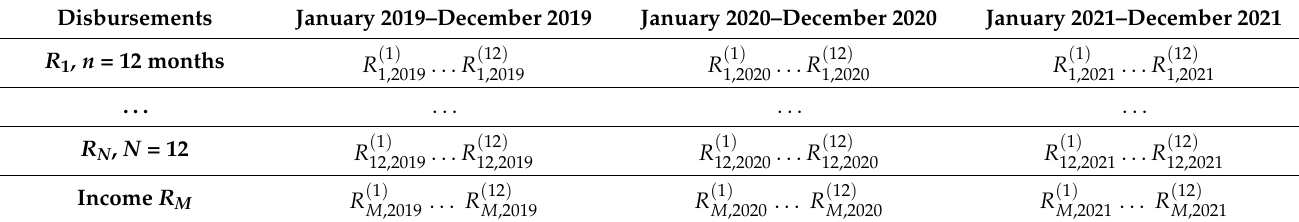
Table 1. Available input data of the husbandry